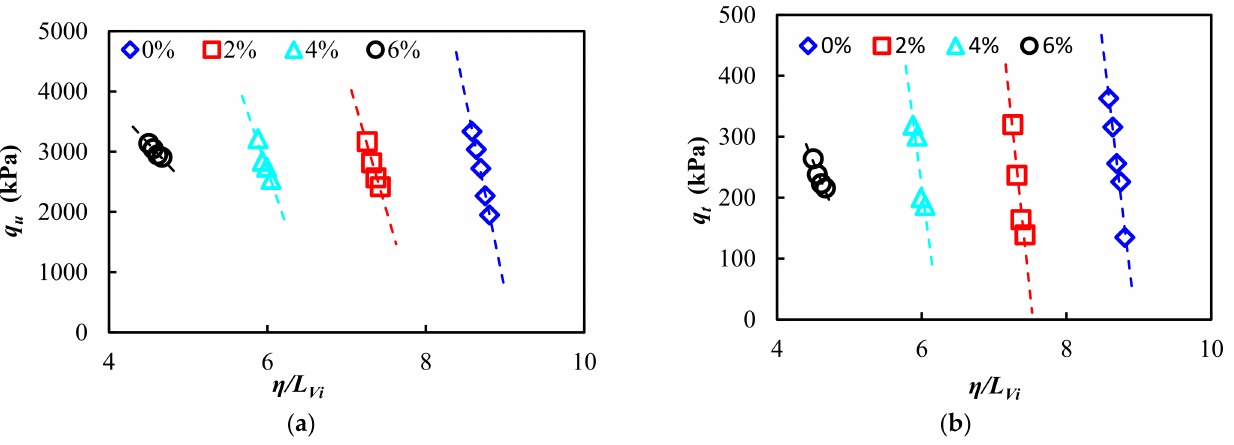
Figure 8. The relationship curves between NFLS strength and η / L Vi at different nano-clay content: ( a ) The relationship curves between UCS and η / L Vi ; ( b ) The relationship curves between STS and η / L Vi